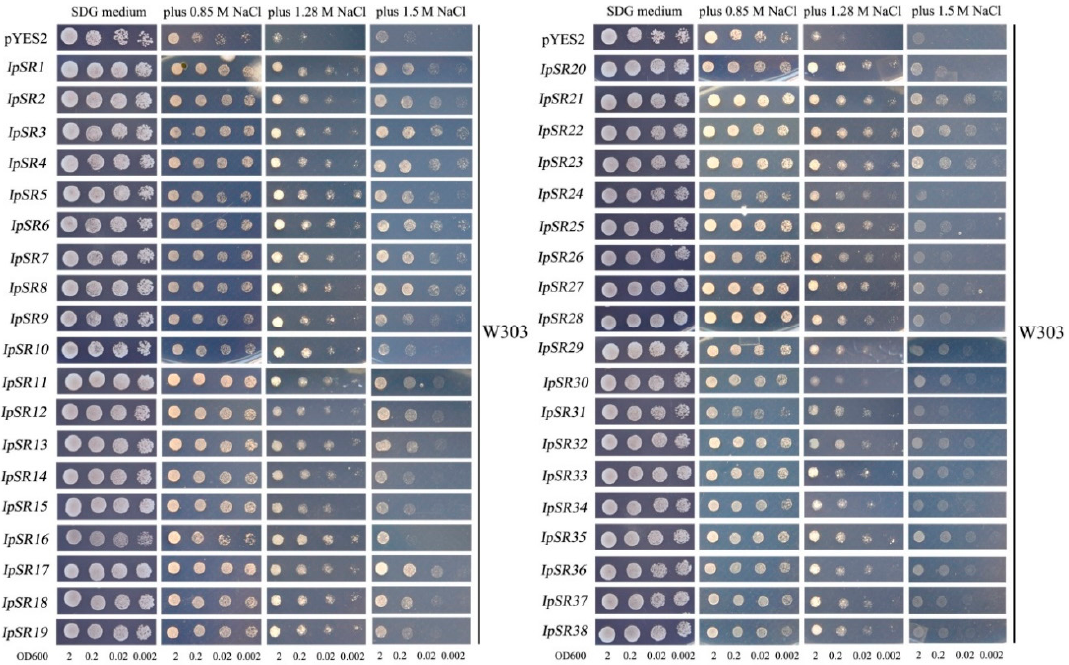
Figure 4. Salinity-tolerance confirmations in yeast wild-type strain W303 of 38 clones ( IpSR1 to 38 ) via library screening from I. pes-caprae . The yeast culture (OD600 to 2) was serially diluted to OD600 values of 0.2, 0.02, and 0.002, and then 2 µ L of yeast liquid was spotted onto SDG-Ura (supplied with adenine/leucine/histidine/tryptophan for W303) plates with (0.85, 1.28, and 1.5 M NaCl) or without NaCl for 5–10 days at 30 °C. The empty vector pYES2 represents negative control.